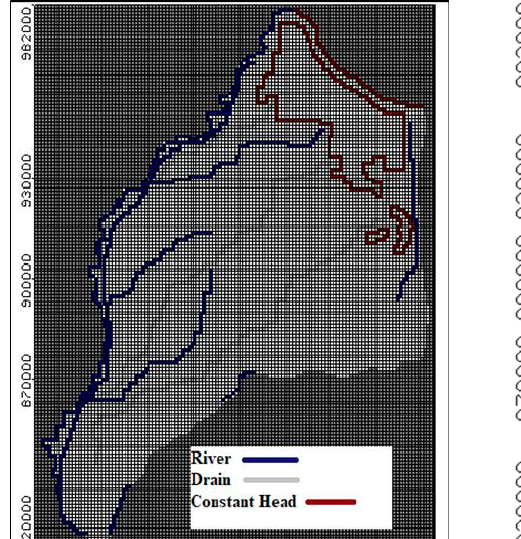
Table 1. Hydraulic parameters of the ENDA.